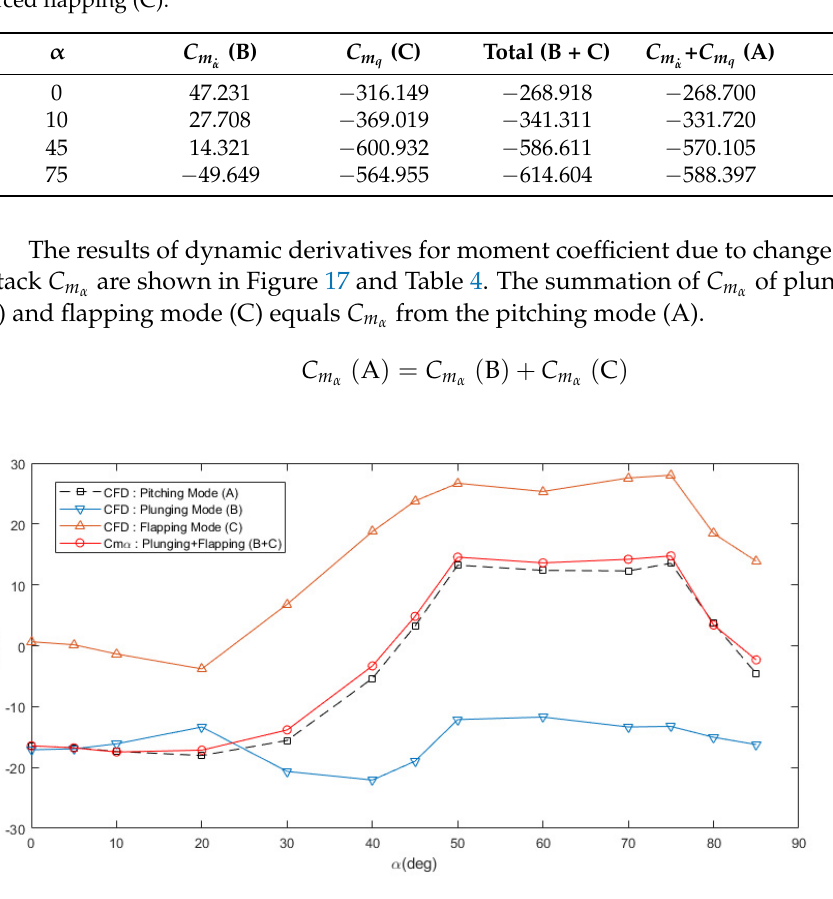
of forced plunging and forced pitching simple harmonic oscillation. Figure 17. Comparison of C m α (cid:3328) between forced pitching ( A ), forced plunging ( B ), and forced flapping ( C ).